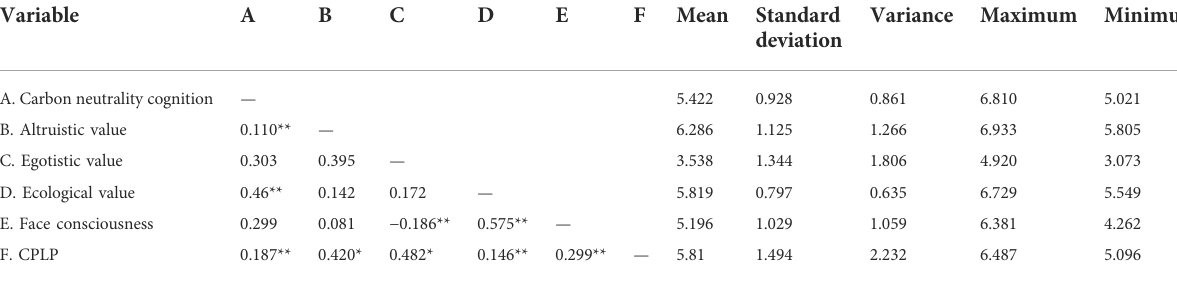
TABLE 3 Pearson correlation coef fi cients among variables and descriptive